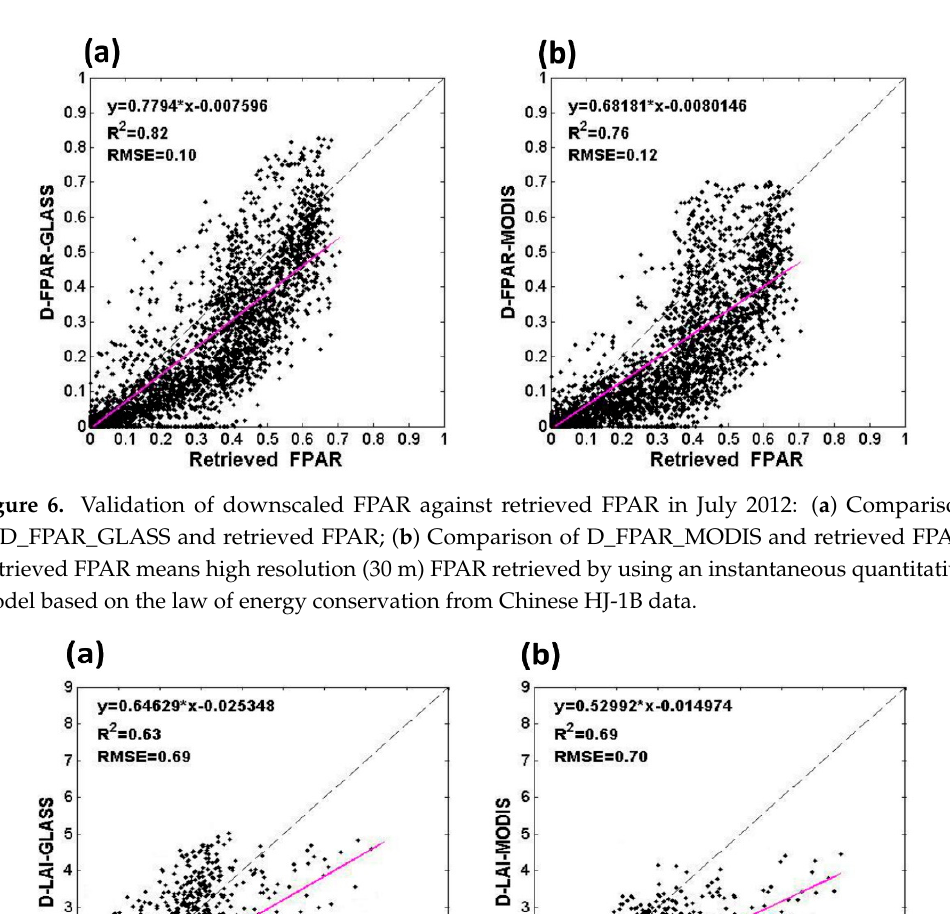
Figure 5. Multi-scale maps of LAI in July 2012: ( a ) GLASS LAI (1 km); ( b ) MODIS LAI (1 km); ( c ) D_LAI_GLASS (30 m); ( d ) D_LAI_MODIS (30 m). The red pixels are the training samples. Compared with MODIS and GLASS 1 km LAI, the downscaled 30 m FPAR demonstrate finer scale features with a clear identification.